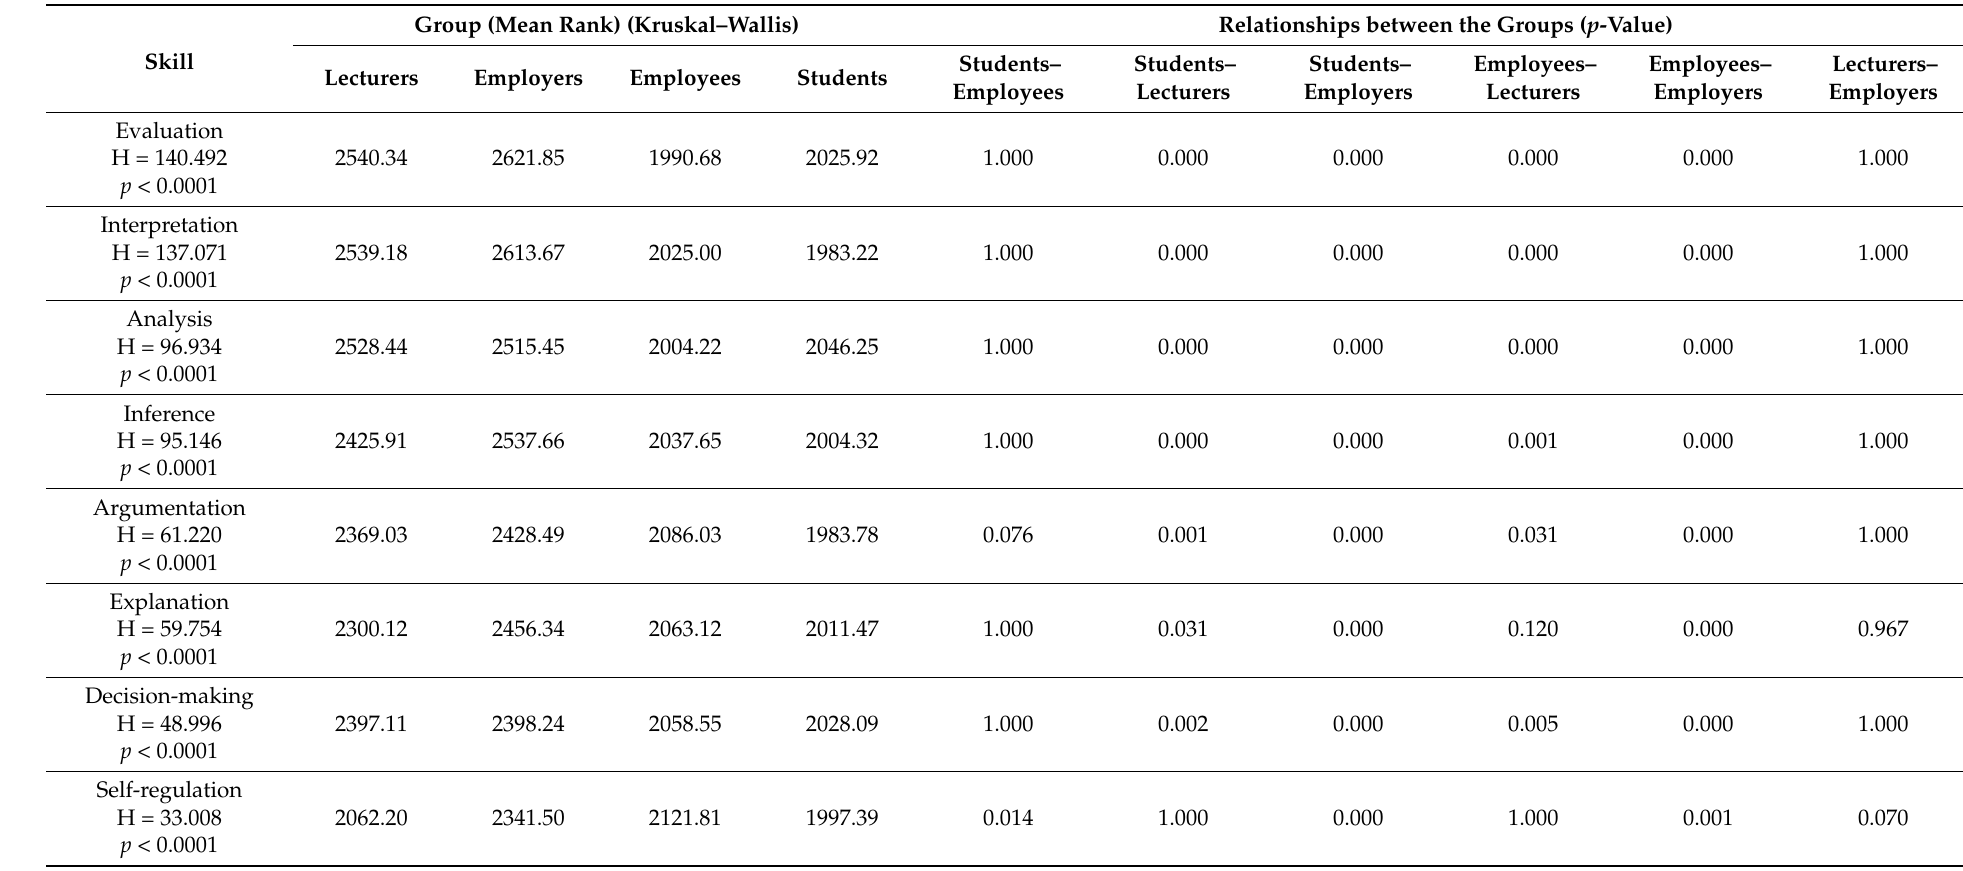
Table 6. Comparison by group of evaluation of the importance of critical thinking skills in the modern labour market.